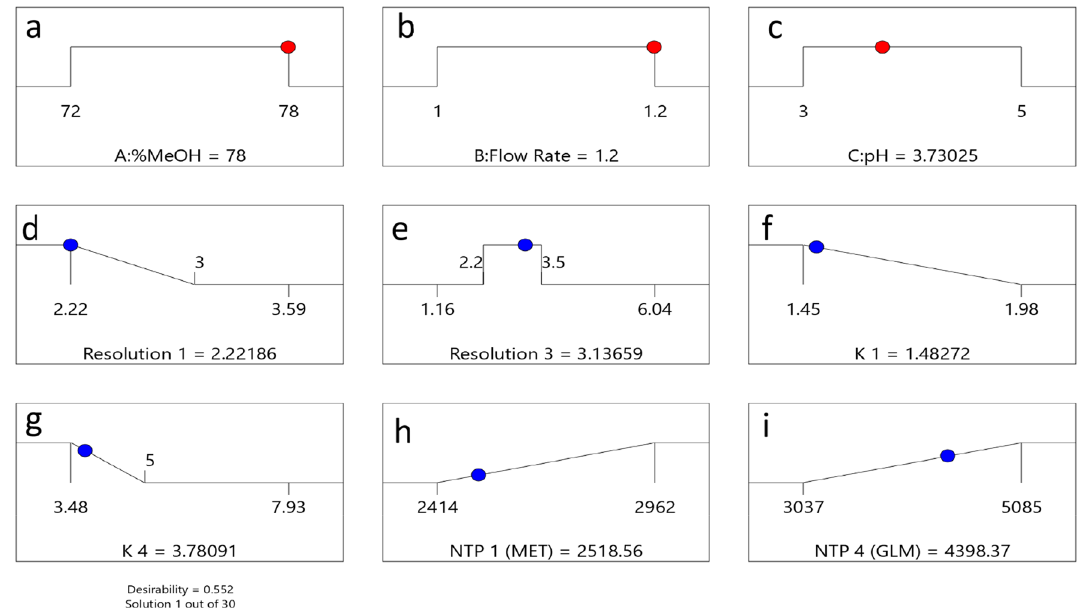
Figure 3. Solution ramps for optimum conditions ( a – i